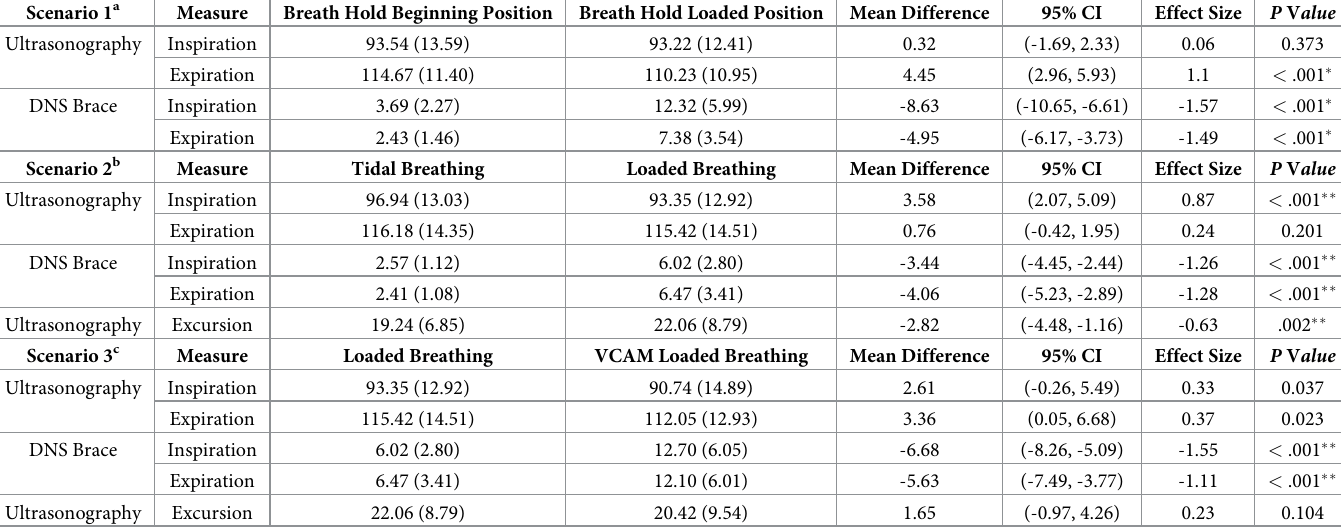
Table 3. Changes in ultrasonography values (mm) and DNS brace values (kPa) during different scenarios of holding a load equivalent to 20% body weight (mean [standard